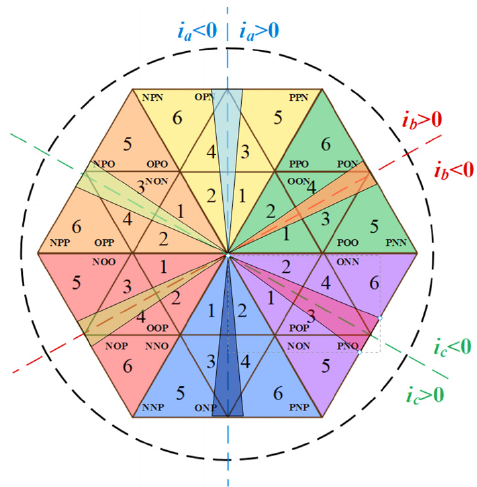
Figure 6. Vienna rectifier Zero-Crossing Distortion Sector Diagram.